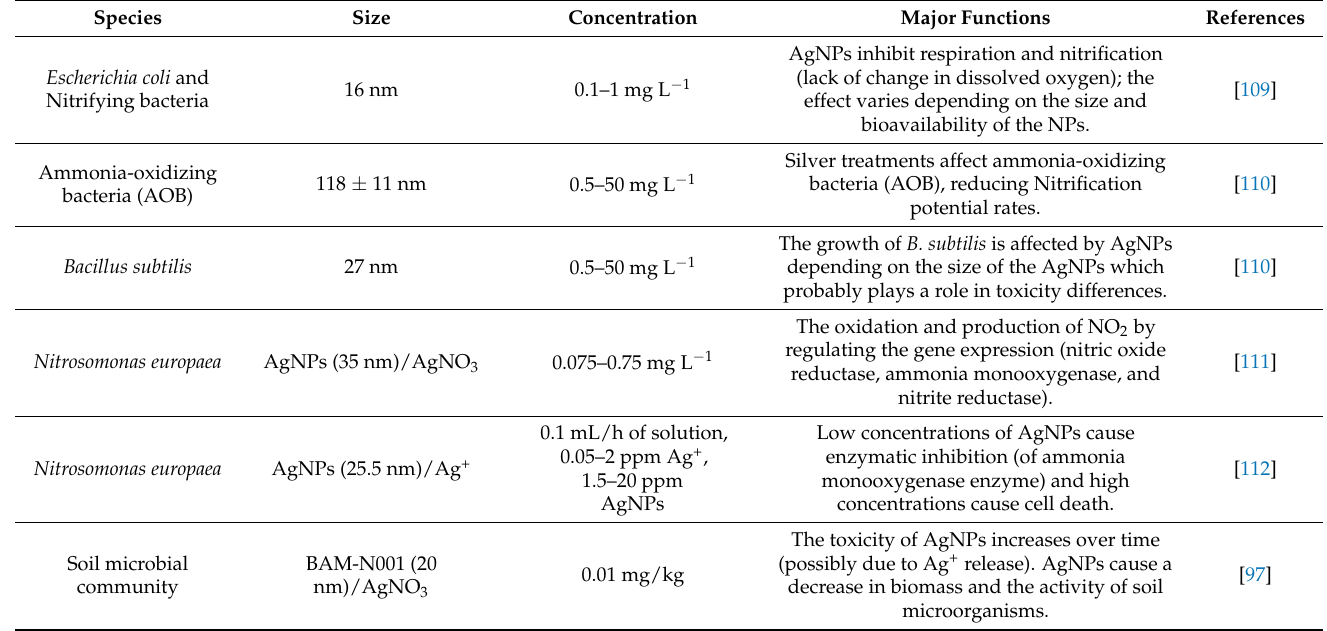
Table 2. Overview on phytotoxicity functions of AgNPs on soil